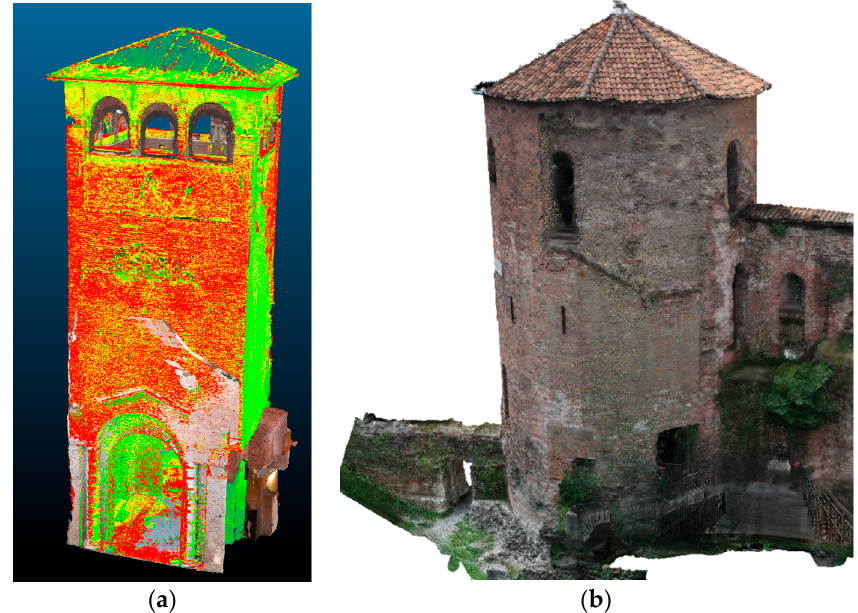
Figure 3. 3D models of structures still standing in the area: ( a ) square tower, belonging to the carceres of the circus. The model was created by the integration of photogrammetry for the interiors and laser scanning for the exteriors; ( b ) polygonal tower, which was part of the late roman city walls. In this case the model was originated exclusively by photogrammetric data.